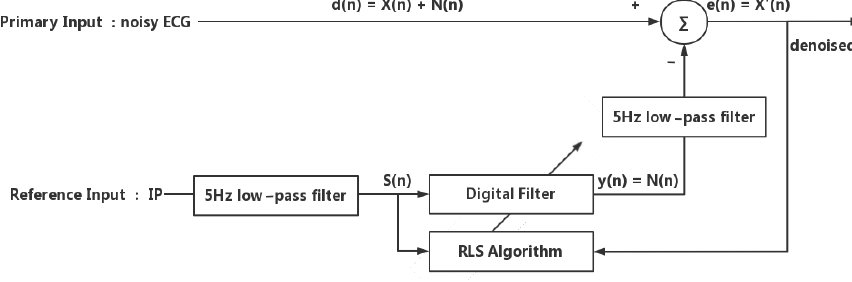
Figure 3. The proposed adaptive motion artifact reduction method.